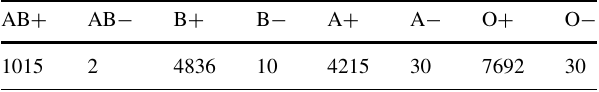
Table 3 Red blood cells with each blood group to be allocated at the Chengdu Blood Center after the Wenchuan Earthquake (U) AB ?